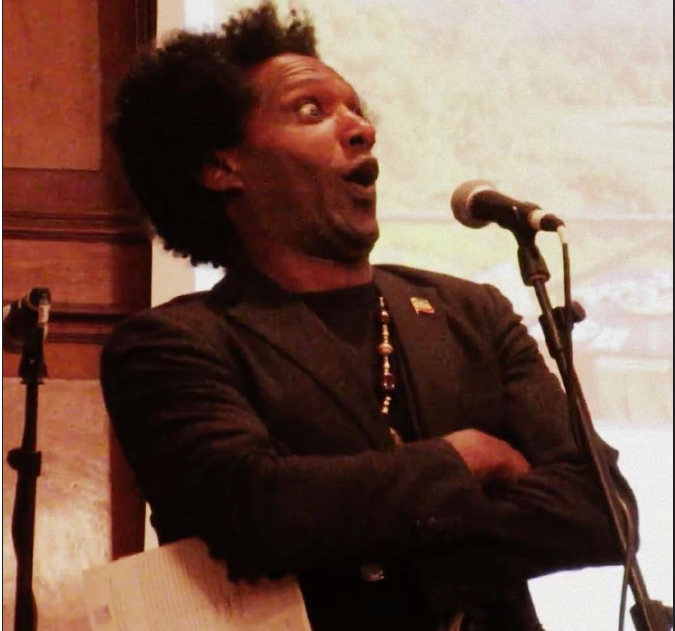
Figure 1 : ‘Lemn Sissay performs his poem Gold from the Stone’ [0:48].